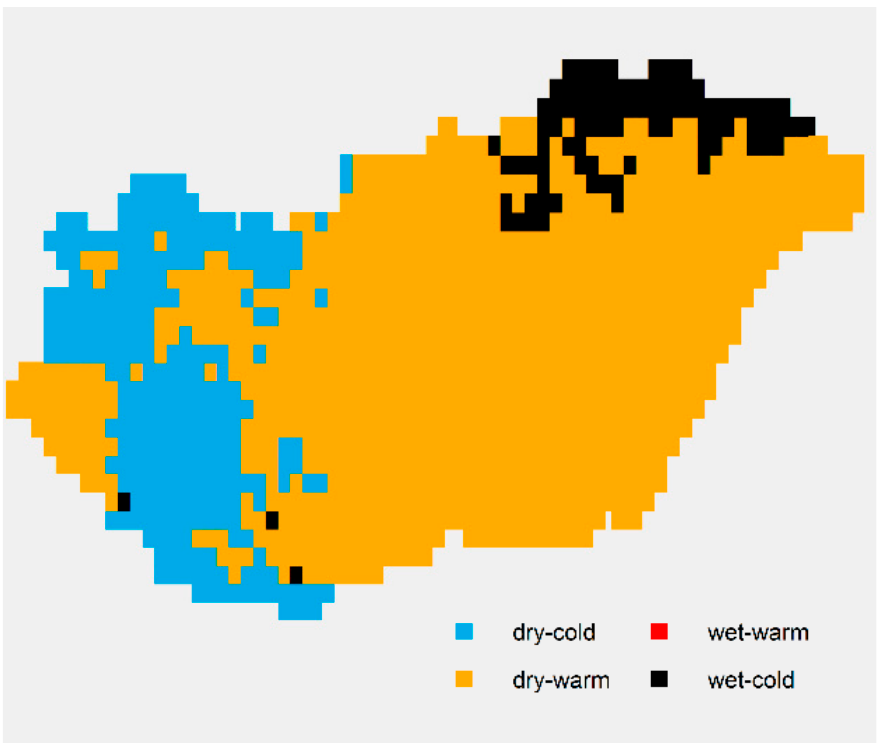
Figure A22. Characteristics of extreme months (December).